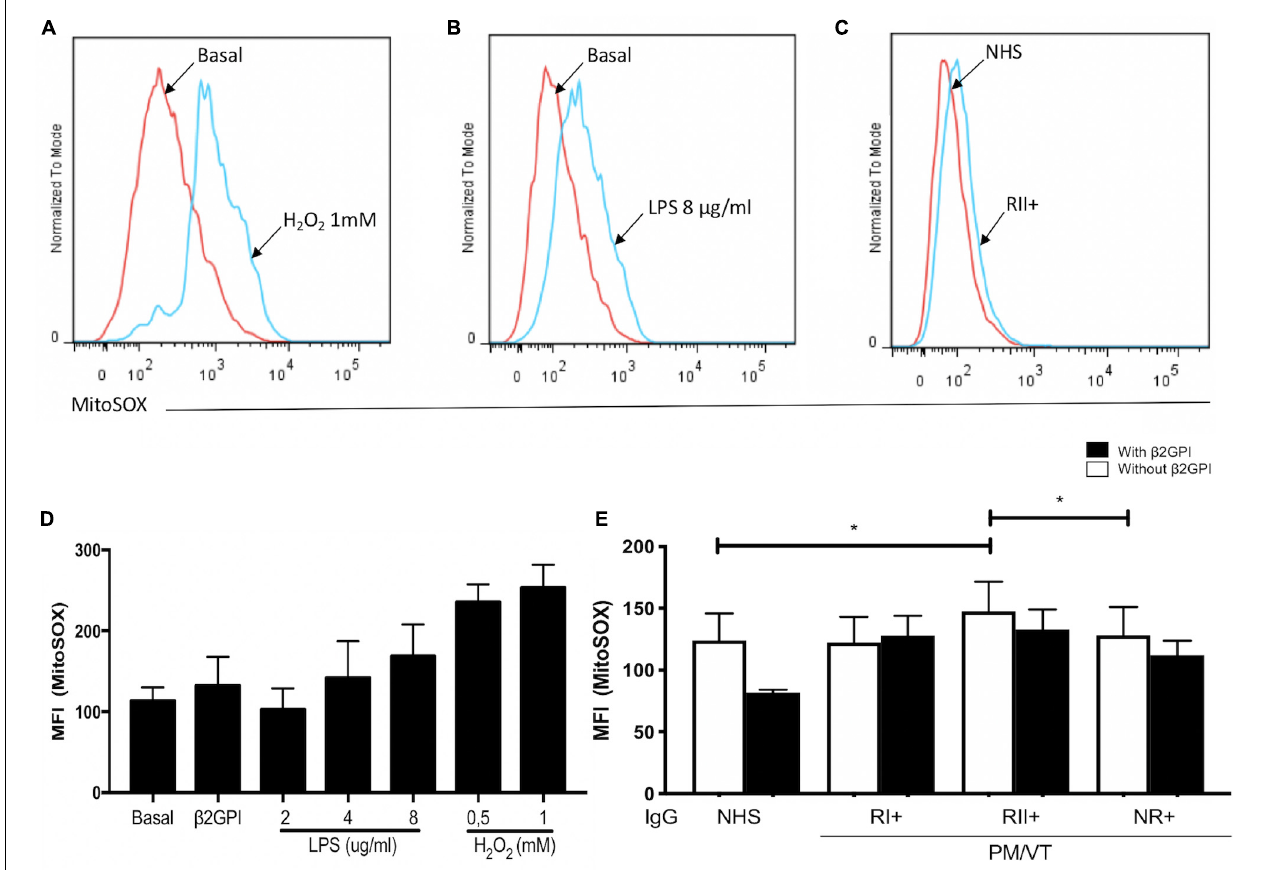
FIGURE 3 | Immunoglobulin-G from patients with refractory and secondary obstetric APS (RII+) induced O 2 − mitochondrial production. (A,B,D) Hydrogen peroxide and LPS increased the MFI of MitoSOX in HUVECs. (C,E) RII + IgG group induced mitochondrial O 2 − production in HUVECs without β 2GPI compared with the IgG from NHS and non-refractory primary obstetric APS (NR+) groups. A two-way ANOVA and the Holm–Sidak post-test (* p < 0.05) were performed. The results were obtained from five independent experiments. (A–C) Representative histograms. PM/VT, pregnancy morbidity and vascular thrombosis.